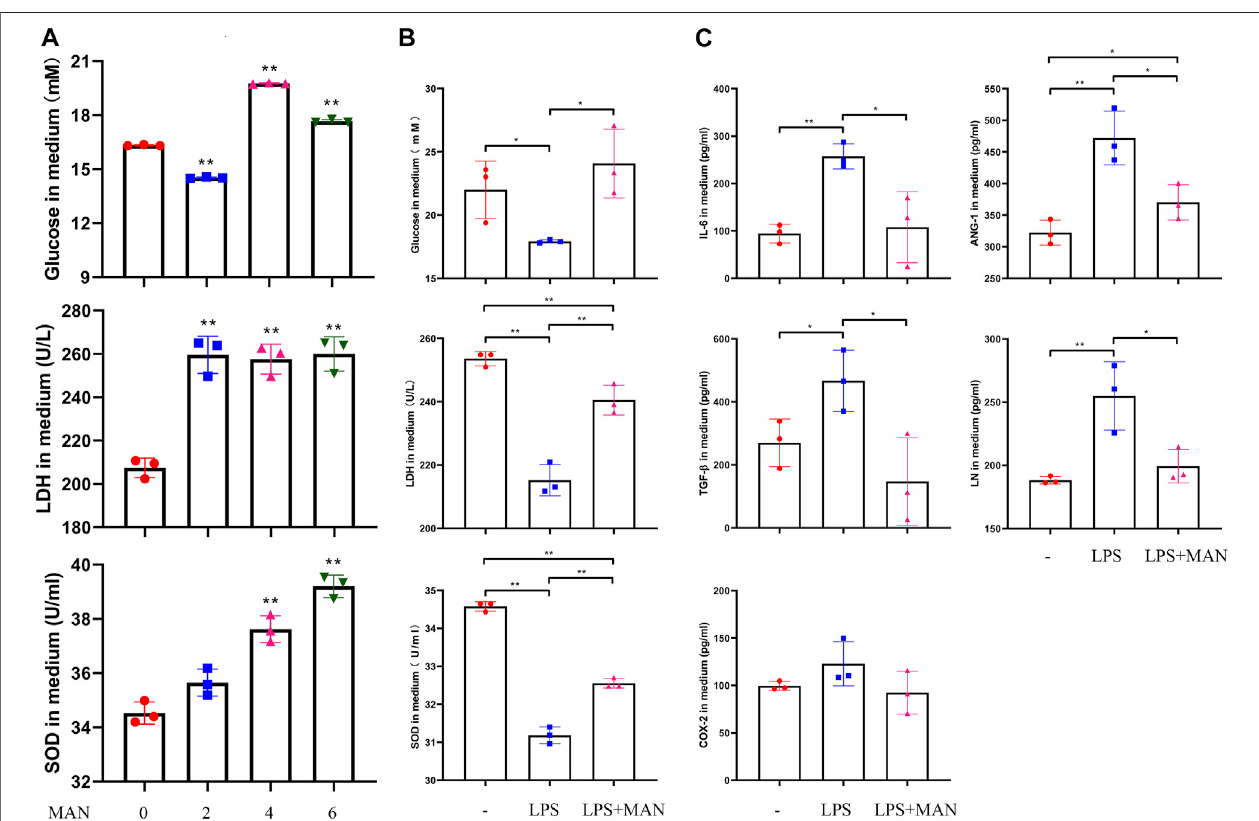
FIGURE7| MAN affectedglucoseoxidation ofHUVECs invitro . (A) , levels ofglucose, LDH and SODin culture medium from thecells receiving MANtreatmentsat various concentrations ( n (cid:2) 3); (B) , levels of glucose, LDH and SOD in culture medium from the cells treated by LPS or in the combination of MAN ( n (cid:2) 3); (C) , levels of angiogenic cytokines released by cells from assay B. Statistical signi fi cances in image A: ** p < 0.01 compared with untreated cells.